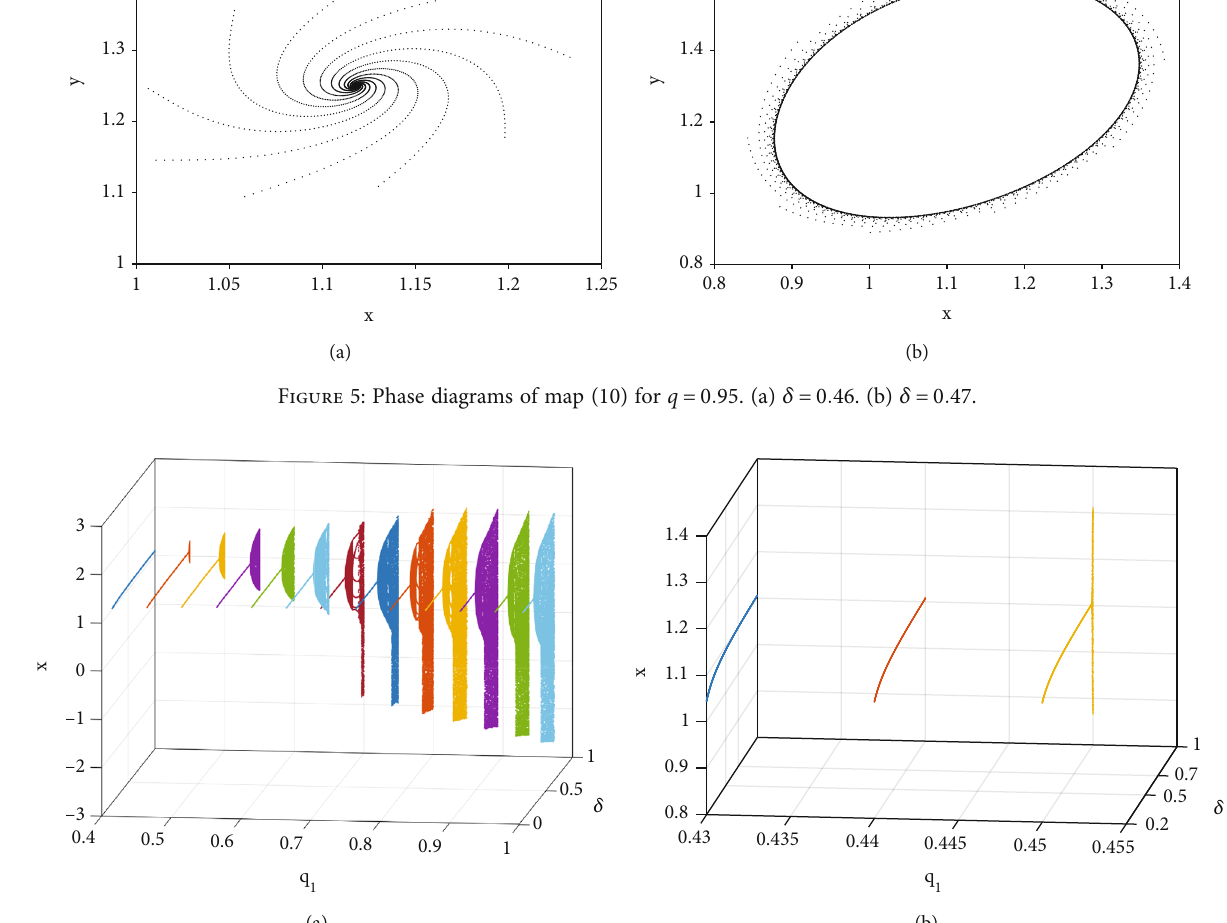
∈ ½ 0 : 43, 0 : 45 (cid:2) . 1